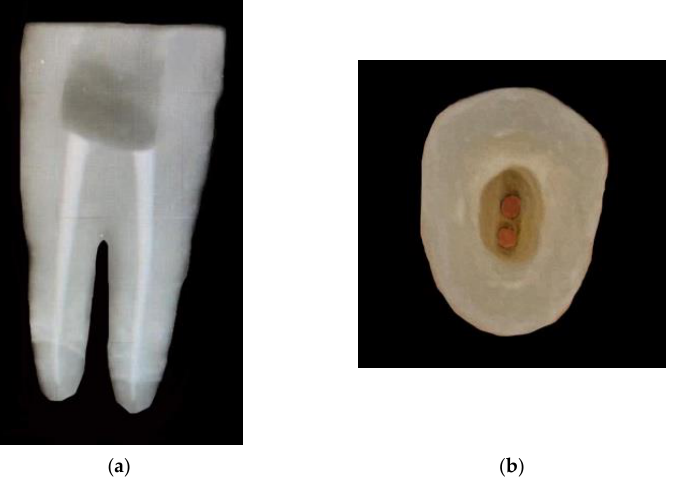
Figure 1. ( a ) Radiographic proximal view of Endocrown preparation without intraradicular extension. ( b ) Occlusal view of Endocrown preparation without intraradicular extension.